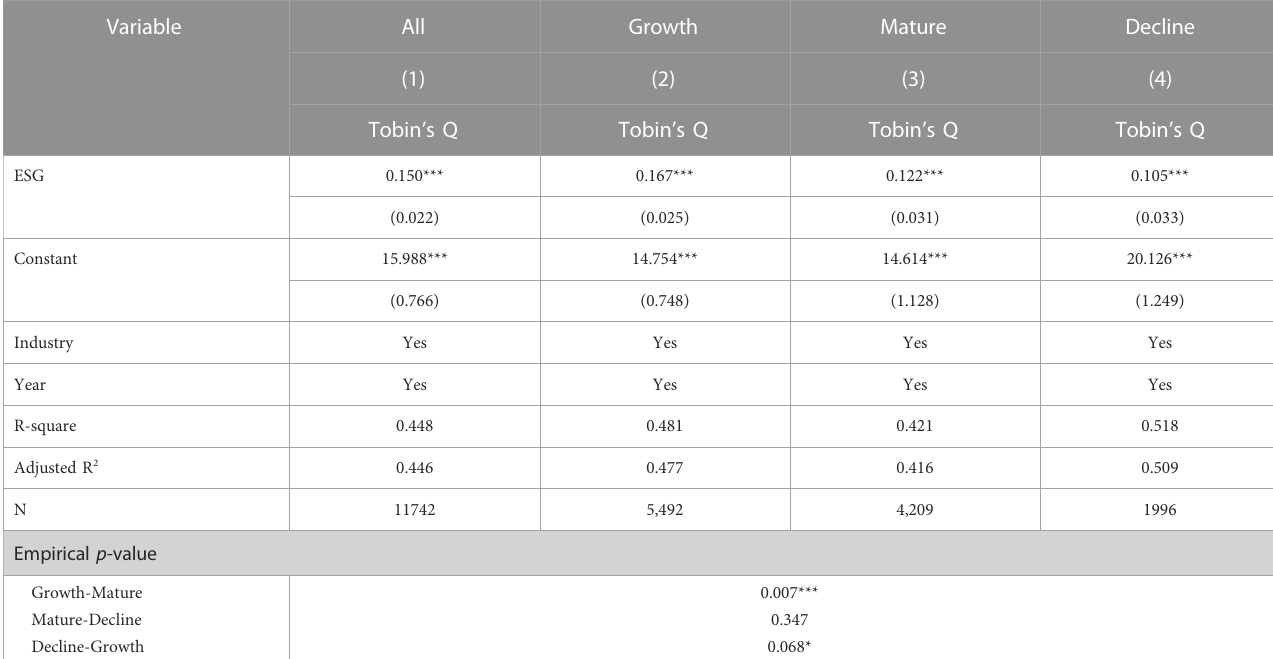
TABLE 7 Basic regression results.